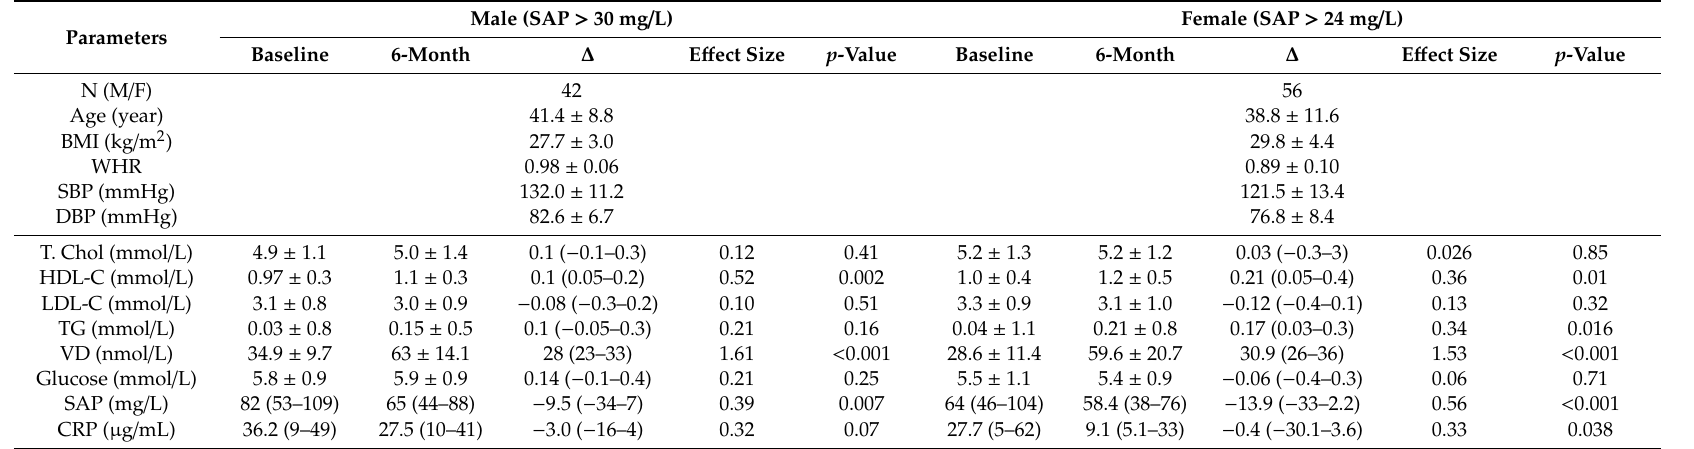
Table 6. Clinical characteristics of responders at baseline and after 6-month intervention using SAP cut-o ff